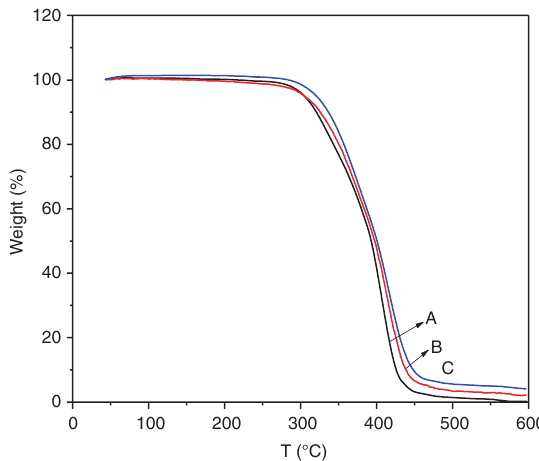
Figure 10: TGA curves of SPUA0 (A), SPUA4 (B), and SPUA8